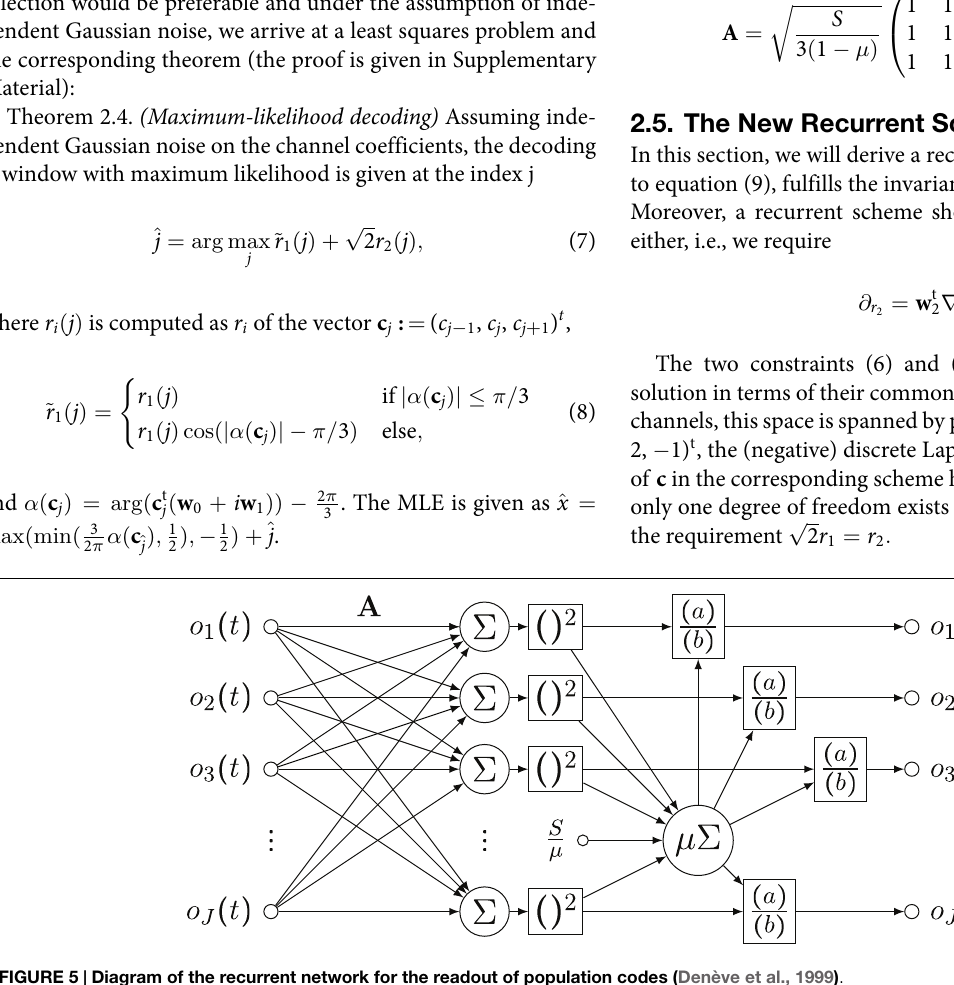
Fr ontiers in Robotics and AI |